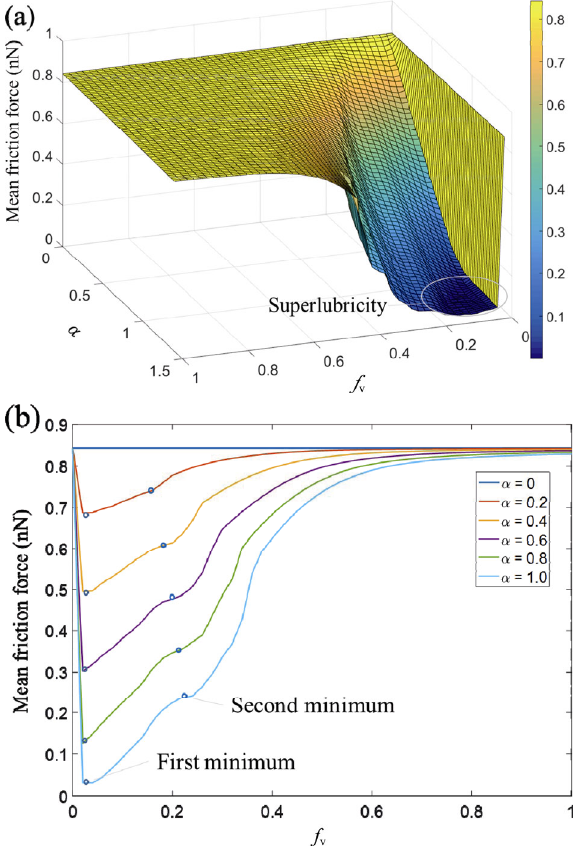
F on  and f : (a) 2D map and v N f and  . v